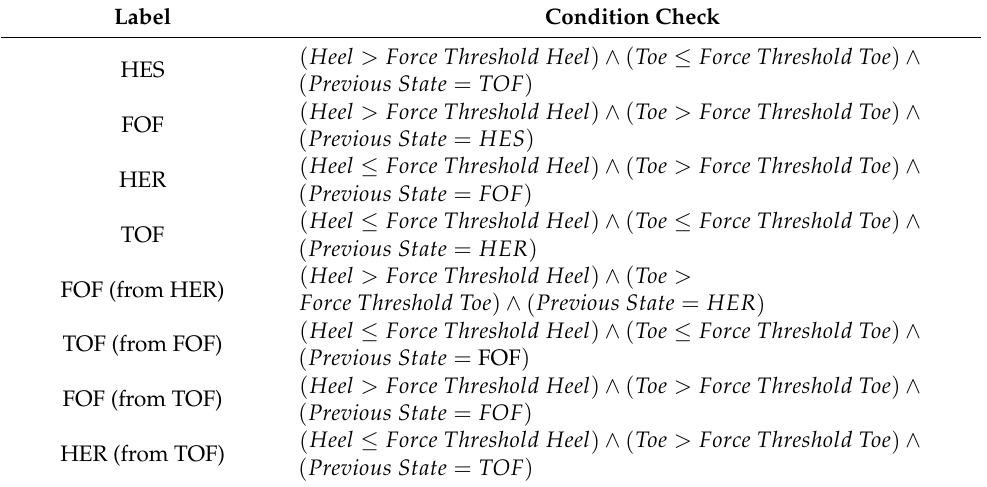
Table 5. The condition checks of the developed gait event detection algorithm for labeling.